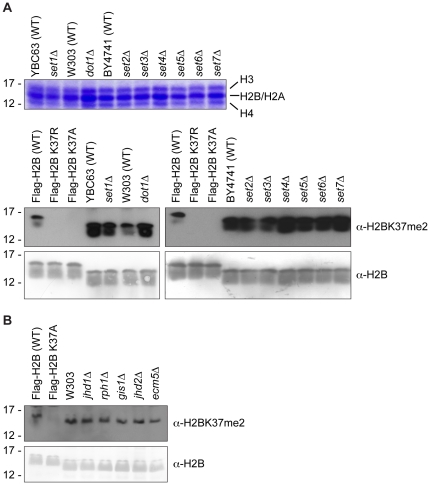
Candidate approach by Western blot analysis does not reveal the methyltransferase and demethylase responsible for H2B lysine 37 methylation.(A) Following validation of correct deletion of the ORF of interest and replacement with kanMX by genomic PCR (data not shown), histones were acid-extracted from candidates from the Yeast Knockout Collection (Open Biosystems), and putative histone methyltransferase activity was tested by Western blot analysis using the purified α-H2BK37me2 antibody. A Coomassie-stained gel illustrating a representative purification of histones is shown in upper panel, and representative Western blots results from the candidate screen are shown below. The blots were first probed with the α-H2BK37me2 antibody (upper) and then striped and reprobed with an α-H2B antibody (lower) to demonstrate equal loading. Histones derived from strains harboring wild-type Flag-H2B (YKG001) and Flag-H2B K37R (YKG006) or K37A (YKG007) were loaded on all gels to demonstrate loss-of-signal upon mutation of lysine 37, thereby serving as a control for antibody specificity. The presence of a Flag-tag on histone H2B results in the slight shift in electrophoretic mobility observed in the control strains, as compared to untagged H2B species in the candidate deletion strains. Deletion of candidate genes did not reveal a putative H2BK37me2 histone methyltransferase by Western blot analysis. (B) Histones were acid-extracted from the five JmjC-domain-containing protein deletions in Saccharomyces cerevisiae, and putative histone demethylase activity was analyzed by Western blot analysis using the purified α-H2BK37me2 antibody. Shown are Western blot results from the candidate screen, in which the blots were first probed with the α-H2BK37me2 antibody (upper) and then striped and reprobed with an α-H2B antibody (lower) to demonstrate equal loading. Again, histones derived from strains harboring wild-type Flag-H2B (YKG001) and Flag-H2B K37A (YKG007) were used as a control for antibody specificity, and the presence of a Flag-tag on histone H2B results in the slight shift in electrophoretic mobility observed in the control strains, as compared to untagged H2B species in the candidate deletion strains. Deletion of each individual candidate did not result in an enhanced signal, suggesting that none of these candidates function as the histone demethylase for H2BK37me2.